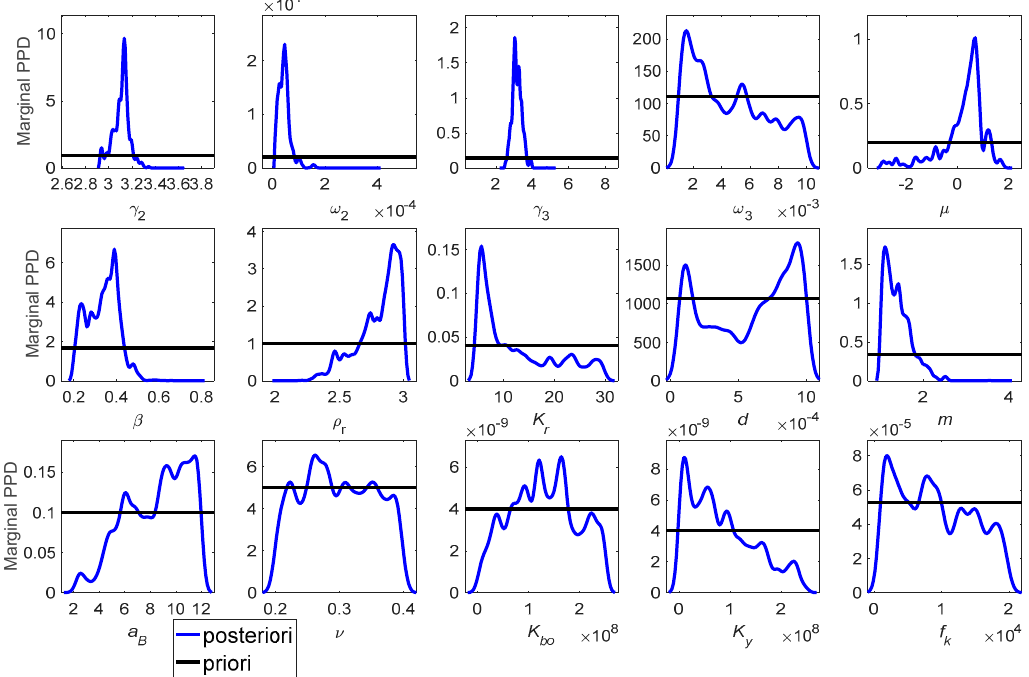
Figure 8. Estimates of one-dimensional marginal PPDs for poroelastic model parameters.